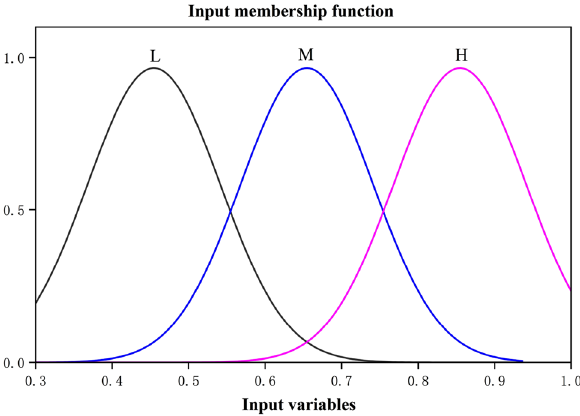
Figure 6. The input membership